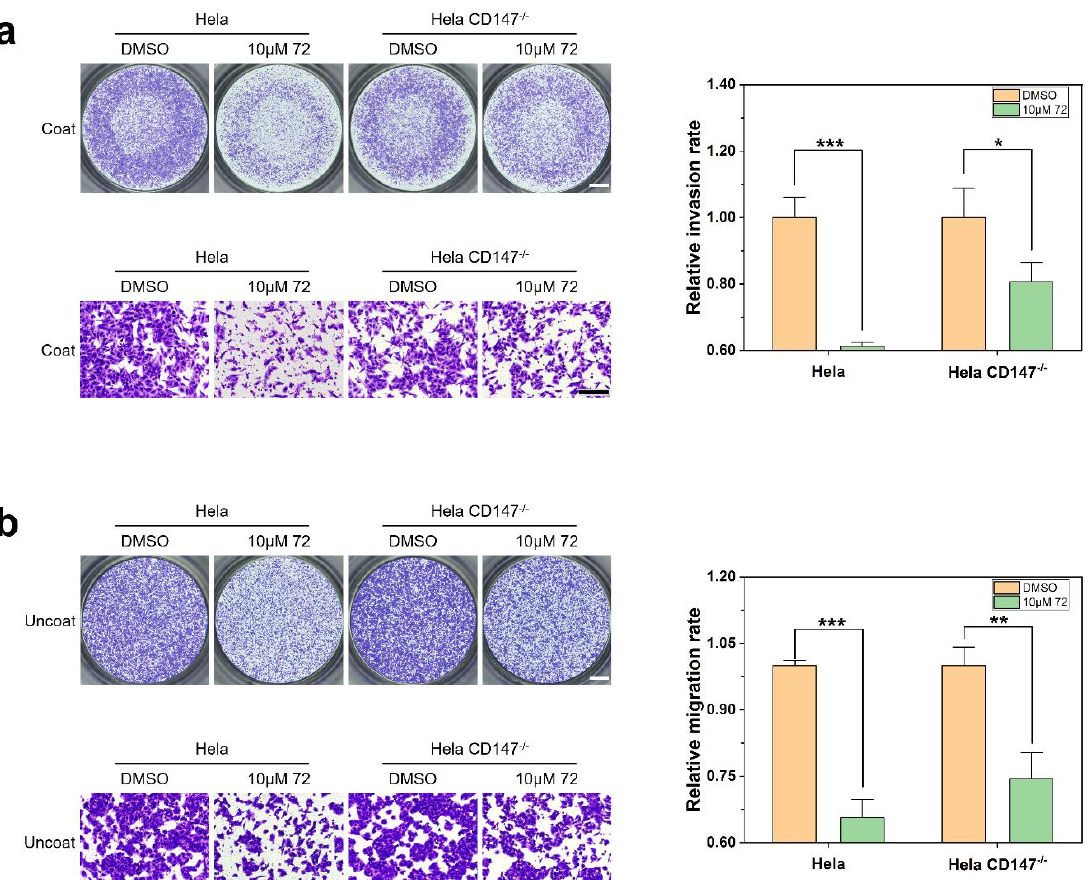
Figure 5. In vitro invasion and migration of Hela and Hela CD147 knockout cells treated with compound 72 for 24 h. ( a ) Effect of compound 72 on cell invasion in Hela and Hela CD147 knockout cells. Scale bars: 1000 μm (upper left) and 200 μm (lower left) (mean ± SD, standard deviation was calculated with three replicates). ( b ) Effect of compound 72 on cell migration in Hela and Hela CD147 knockout cells. Scale bars: 1000 μm (upper left) and 200 μm (lower left) (mean ± SD, standard deviation was calculated with three replicates). * p < 0.05, ** p < 0.01, *** p < 0.001.